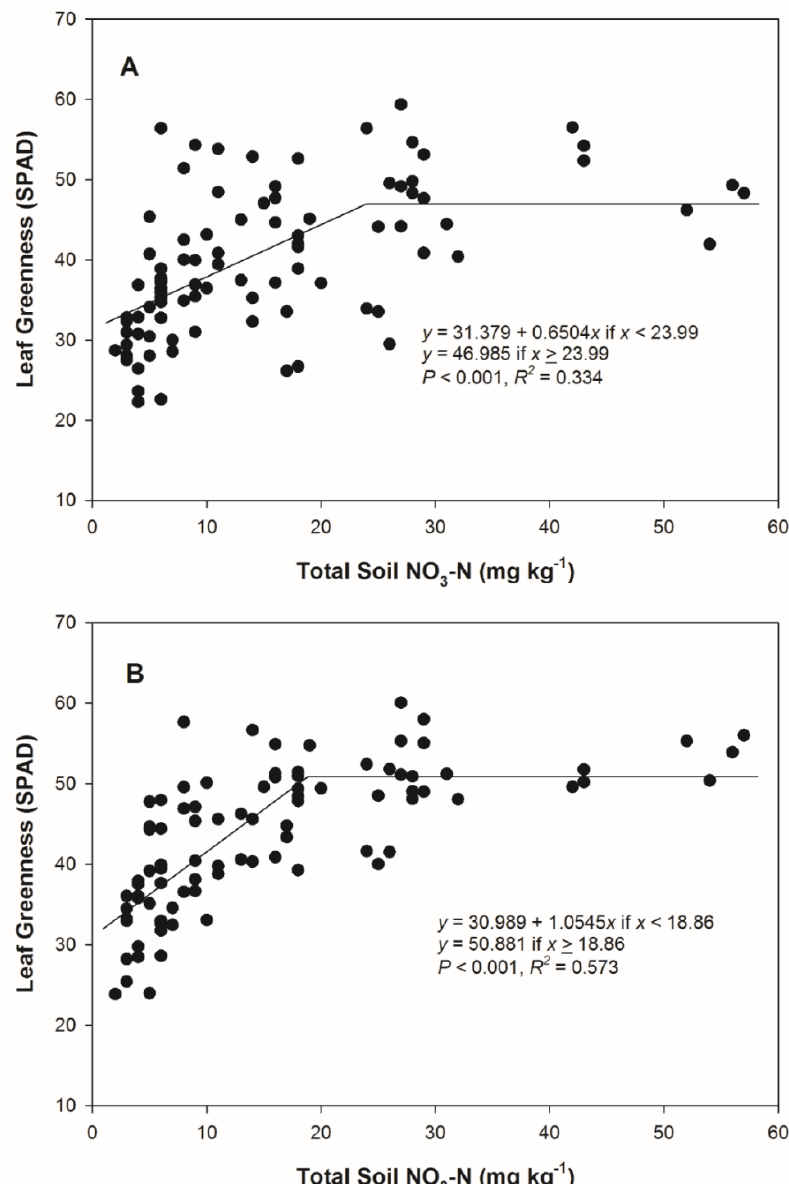
Figure 3. ( A ) Leaf greenness (as SPAD) 14 days after flood initiation (DAFI) as impacted by soil nitrate-nitrogen (NO 3 -N) level 14 DAFI in 2018. ( B ) Leaf greenness (as SPAD) 21 DAFI as impacted by total soil NO 3 -N level 14 DAFI in 2018.